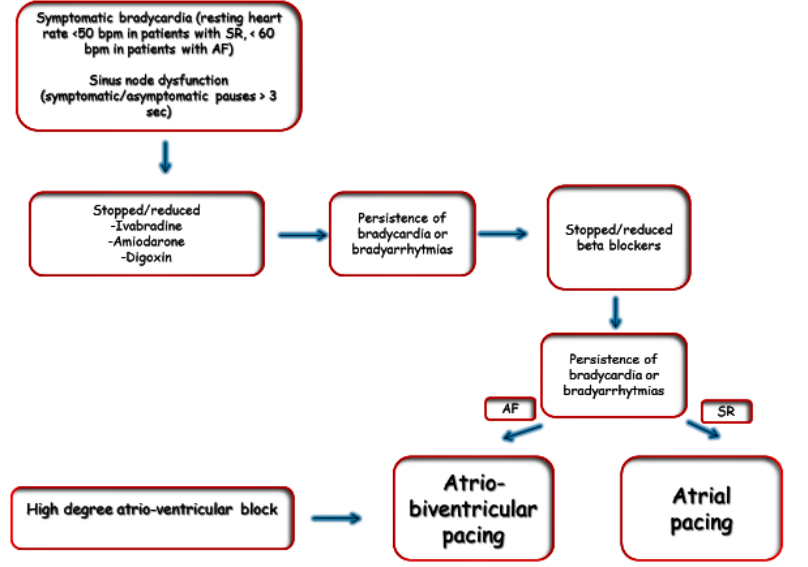
Figure 2. Flow chart for management of bradyarrhythmias in HF. AF: Atrial fibrillation; SR: Sinus Rhythm.